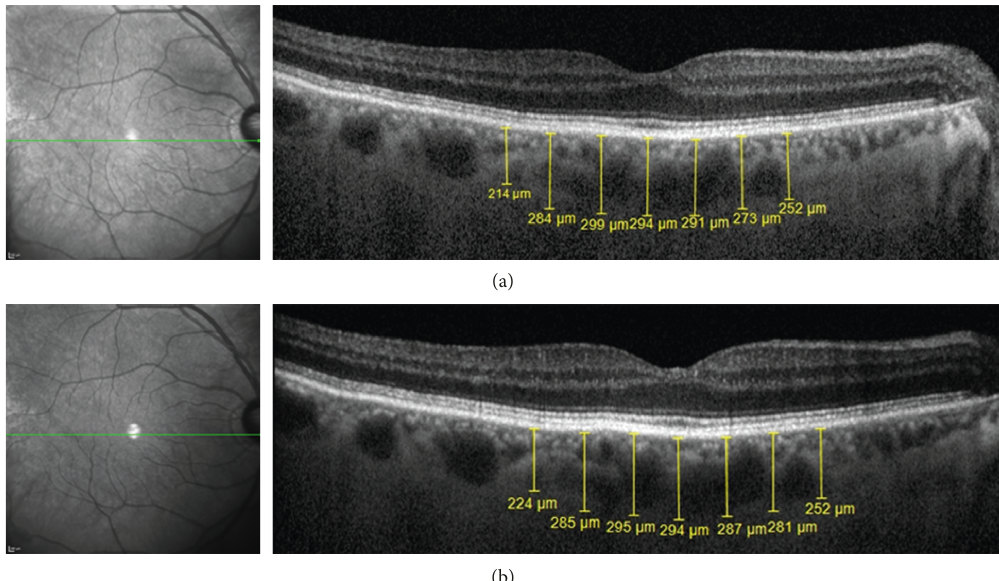
Figure 3: Patient #7: a 75-year-old male, with a past medical history of hypertension, CVA, CAD, hypercholesterolemia, and smoking (40 pack-years), presented with right ICA stenosis of 90%. His BCVA at presentation was RE 6/7.5 and LE 6/7.5. Moderate nuclear sclerosis was present in both eyes with no pathological findings in the funduscopy of both eyes. He underwent an uneventful CEA, and on follow-up, there was no right ICA stenosis at all. EDI SD-OCT images of the RE, with choroidal thickness measurements (subfoveal; 500 µ m, 1000 µ m, and 1500 µ m nasal and temporal), obtained one day before right CEA (a) and 14 months after CEA (b). CVA: cerebrovascular accident; CAD: coronary artery disease; ICA: internal carotid artery; BCVA: best-corrected visual acuity; RE: right eye; LE: left eye; CEA: carotid artery endarterectomy; EDI: enhanced depth imaging; SD-OCT: spectral domain optical coherence